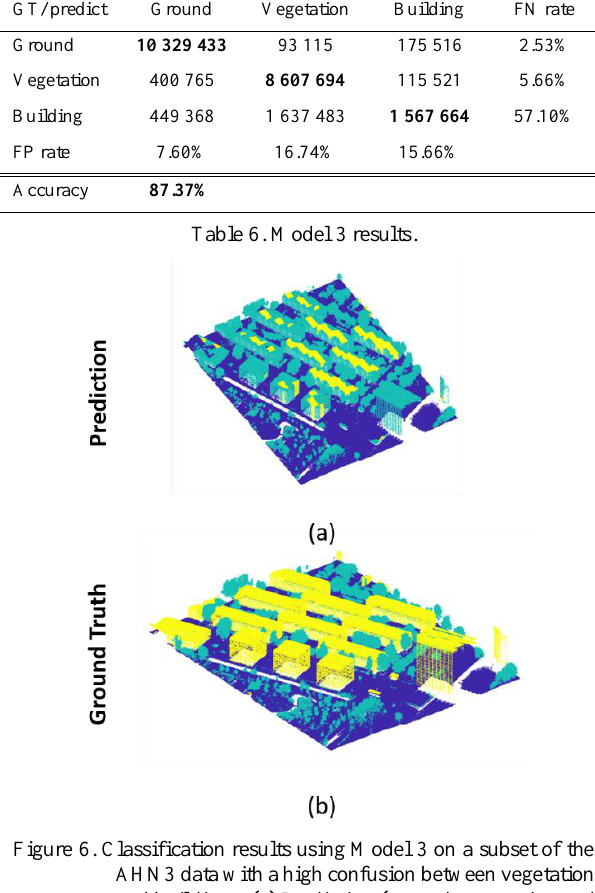
Figure 5. Classification results using Model 2 on a subset of the AHN2 test data. (a) Prediction (ground, vegetation and buildings are coloured as blue, green and yellow respectively). (b) Ground truth. Many roof points are classified as vegetation